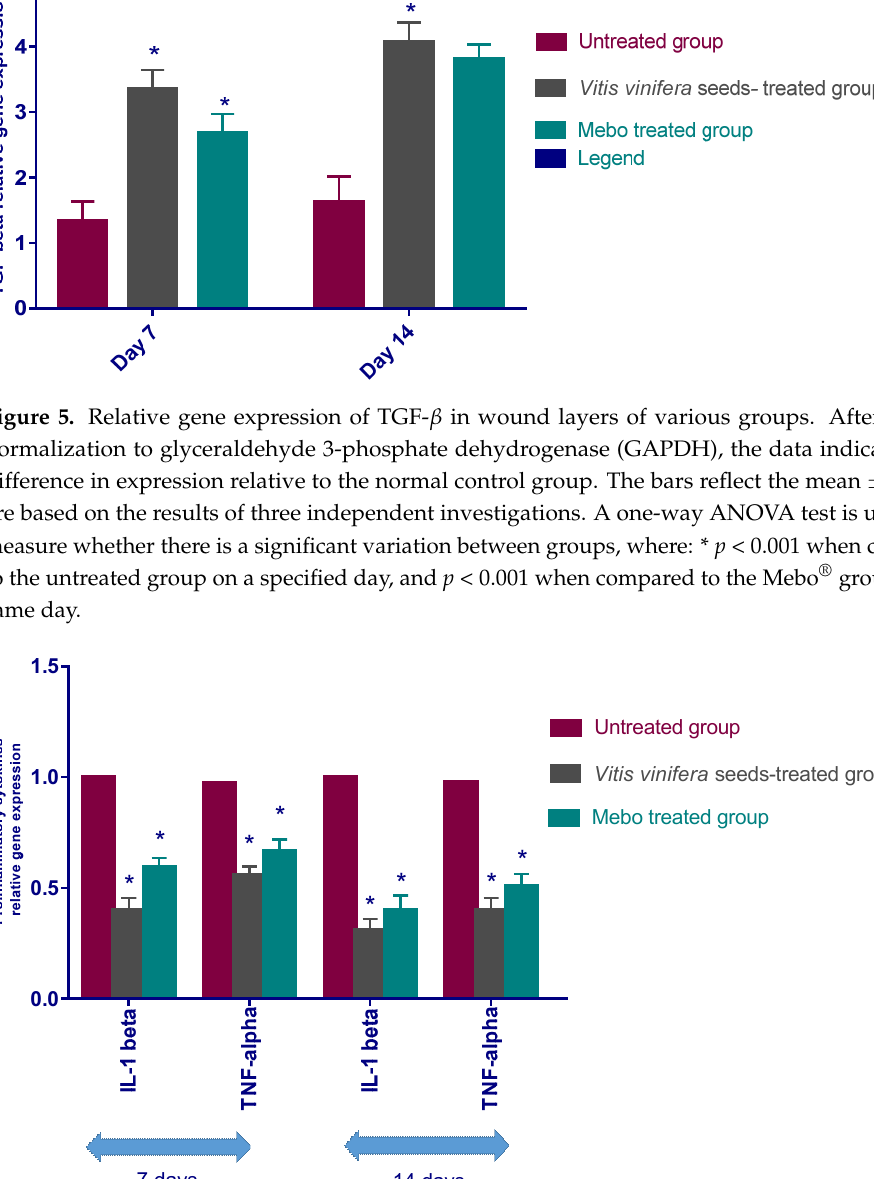
Figure 5. Relative gene expression of TGF- β in wound layers of various groups. After making nor- malization to glyceraldehyde 3-phosphate dehydrogenase (GAPDH), the data indicate a fold differ- ence in expression relative to the normal control group. The bars reflect the mean ± SD and are based on the results of three independent investigations. A one-way ANOVA test is utilized to measure whether there is a significant variation between groups, where: * p < 0.001 when compared to the untreated group on a specified day, and p < 0.001 when compared to the Mebo ® group on the same day.